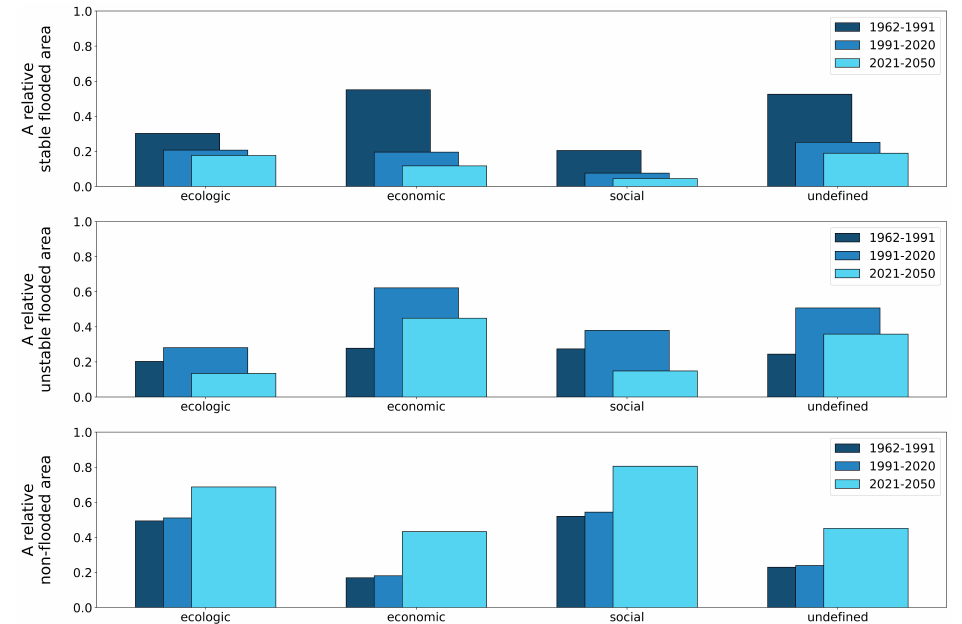
Figure 20. Diagrams of the elements dynamics of the complex structure for T =